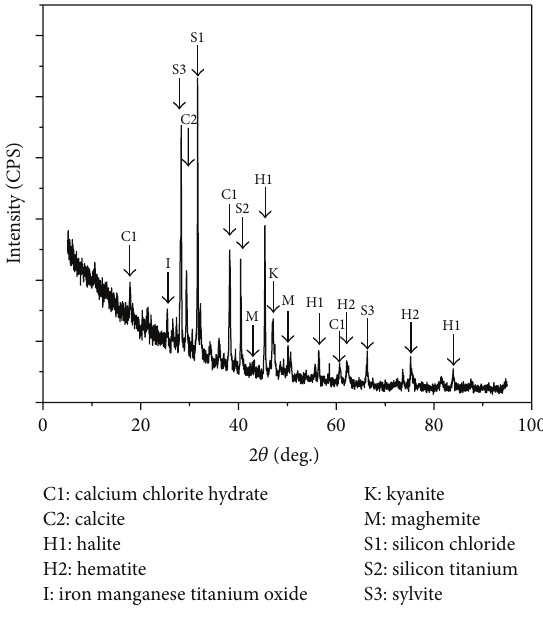
Figure 5: XRD pattern of fly